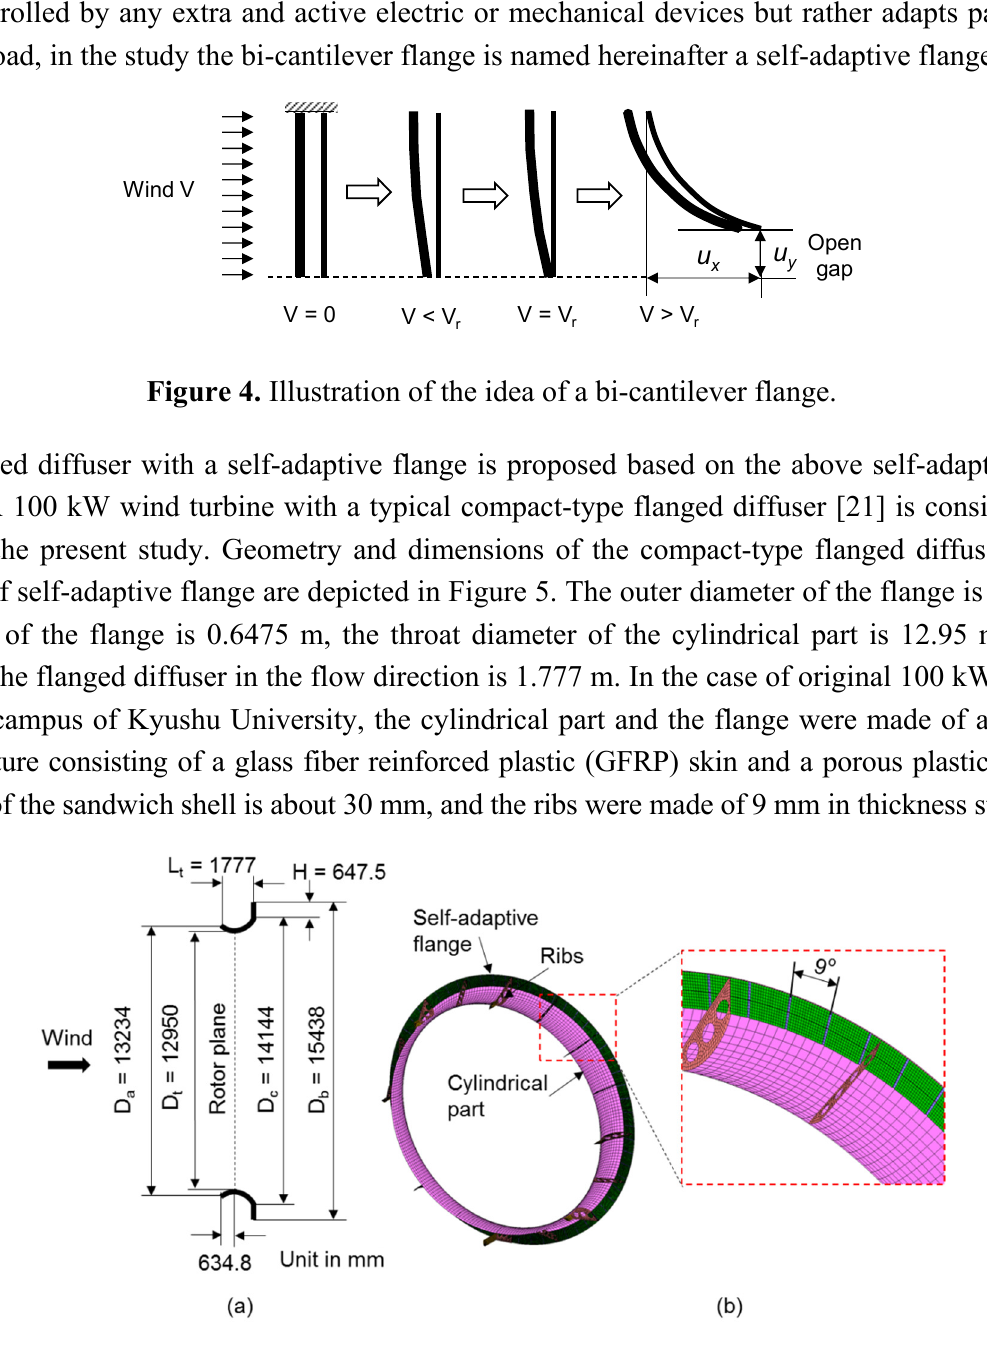
Figure 5. A compact-type flanged diffuser with a self-adaptive